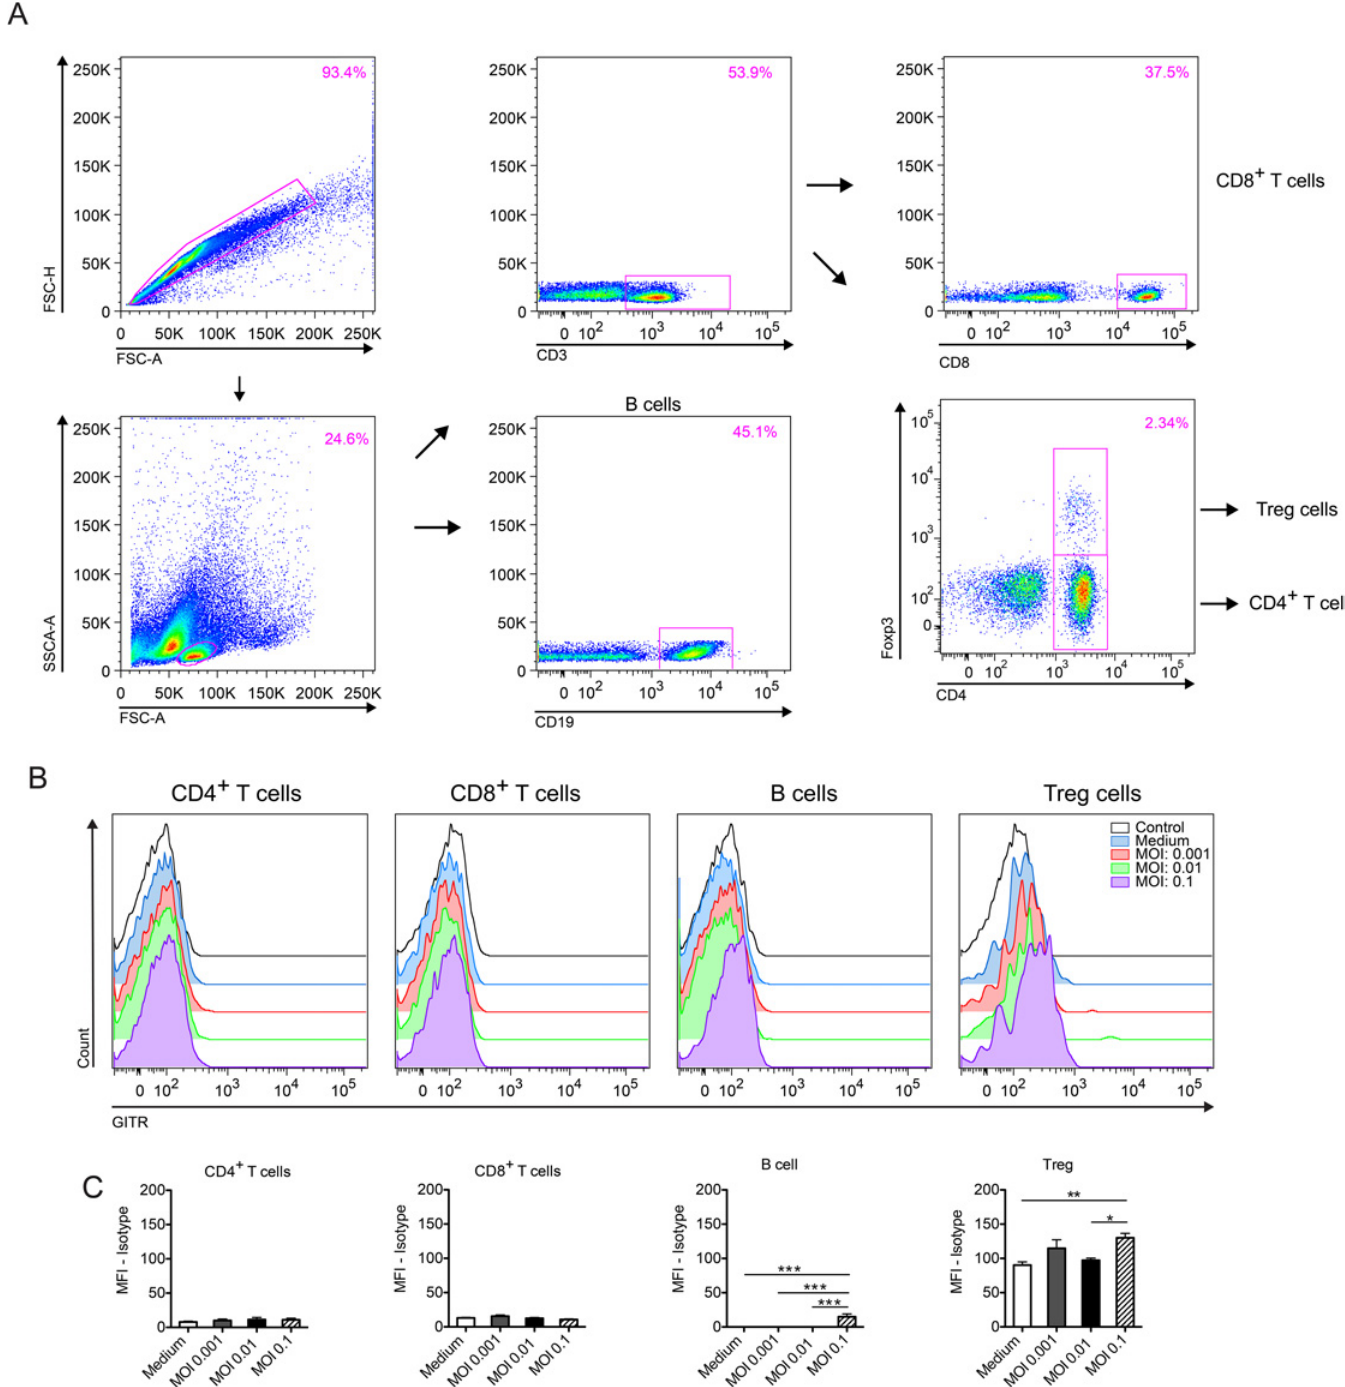
Fig 1. GITR expression in the lymphocyte compartment. Splenocytes from na ï ve C57BL/6 mice were collected, stimulated or not with tachyzoites of the ME-49 strain at different MOIs (MOI: 0.1; 0.01 and 0.001) and kept in culture for 24 hours. GITR expression was then analyzed by flow cytometry. Gating strategy is depicted in (A), histogram plots in (B) and MFI expression in (C). The lymphocytes were first identified and gated based on their FSC and SSC profile after doublets exclusion. Treg cells were considered as CD3 + CD4 + Foxp3 + T cells gated on the lymphocyte region. Error bars indicate mean +/- SEM. * P < 0.05 and ** P < 0.01. The experiment was performed twice with six technical replicates in each experiment.